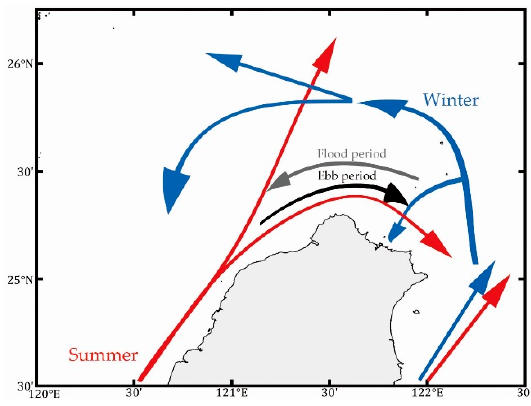
Figure 17. A schematic diagram of the main characteristics of the flow field in the north of Taiwan.